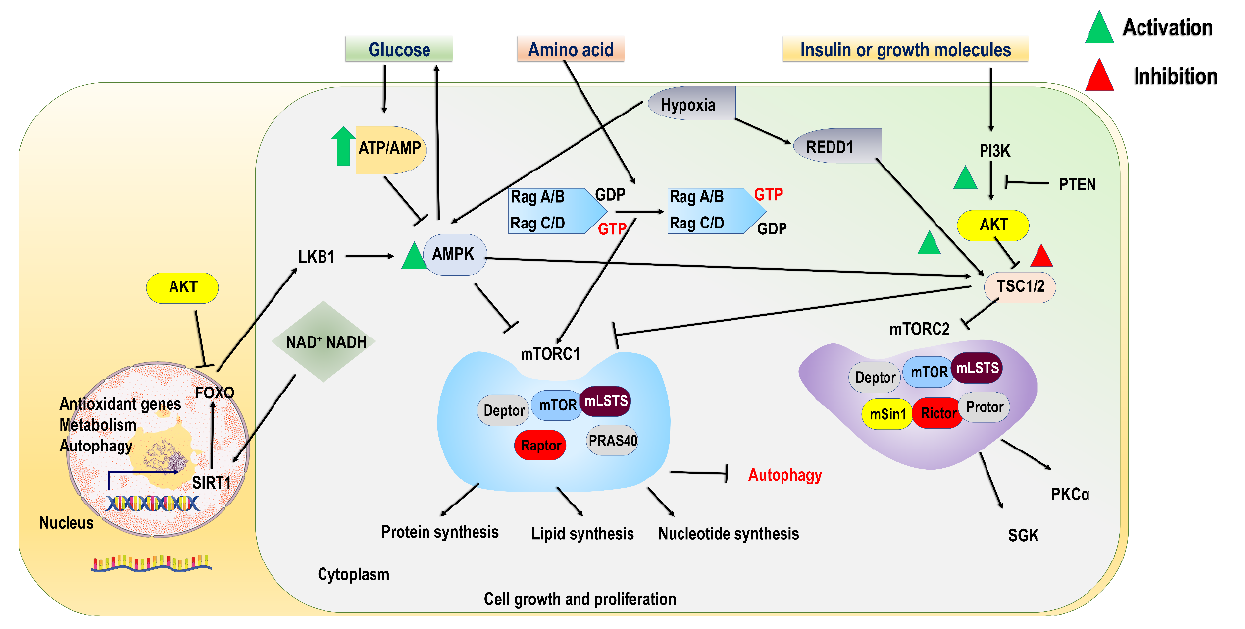
Figure 2. Nutrient signalling to mTOR: Cells possess a sensing system that senses nutrients and metabolites for proper communication and the regulation of cell signalling and metabolic status.